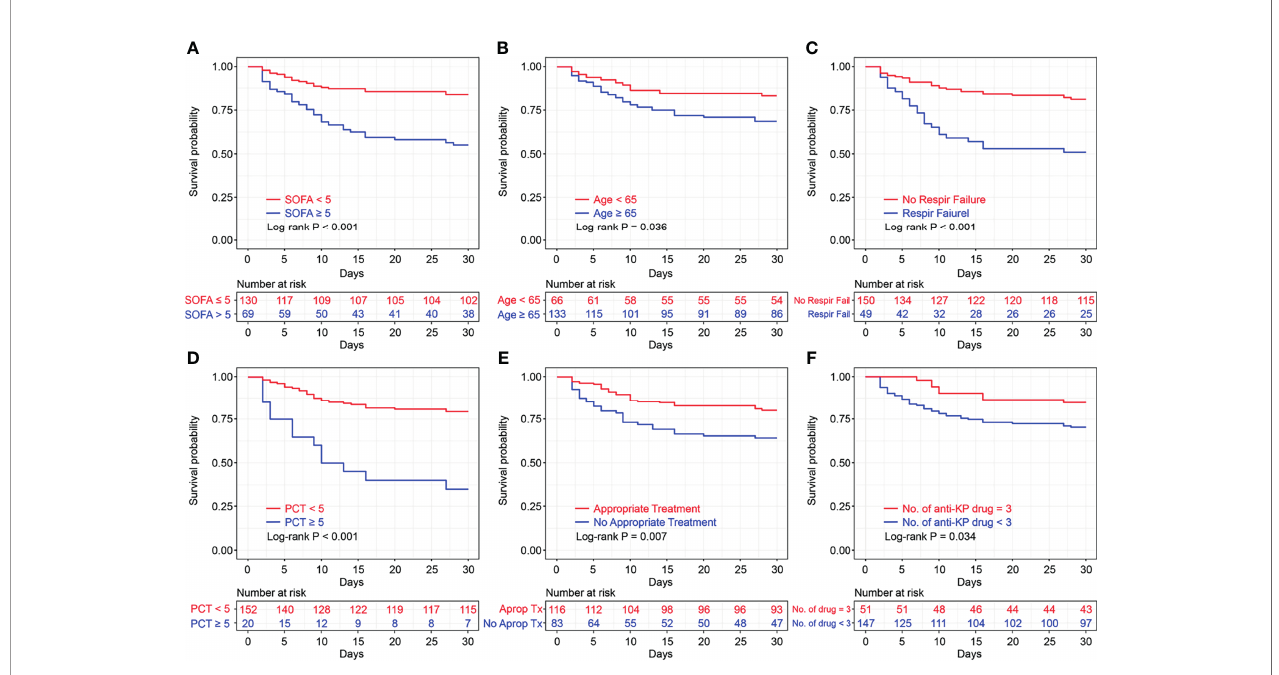
FIGURE 1 | Kaplan – Meier survival plots of Sequential Organ Failure Assessment score (A) , age (B) , respiratory failure (C) , procalcitonin (D) , appropriate treatments in 3 days (E) , and number of anti-KP drugs (F) , with log-rank test. SOFA, Sequential Organ Failure Assessment; PCT, procalcitonin KP, Klebsiella pneumoniae